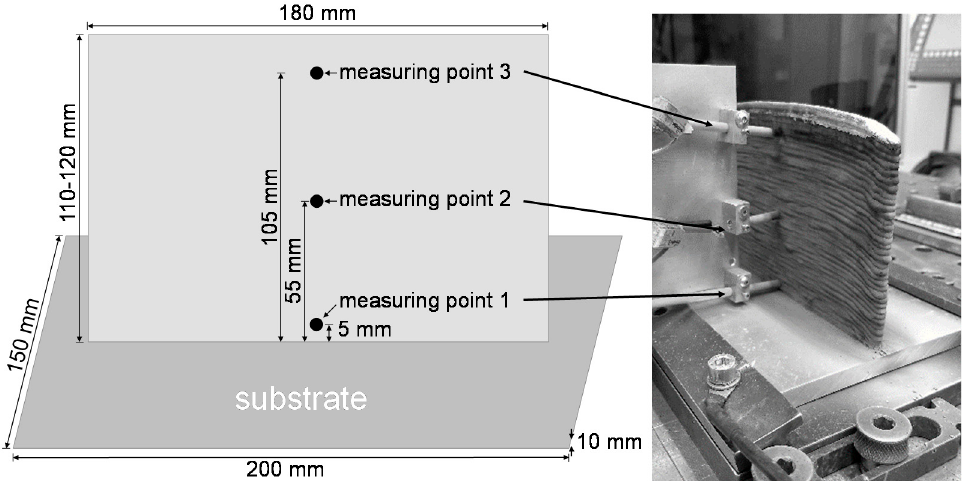
Figure 2. Representation of the placement of the temperature measuring points and dimensions of the substrate and the built wall structures.